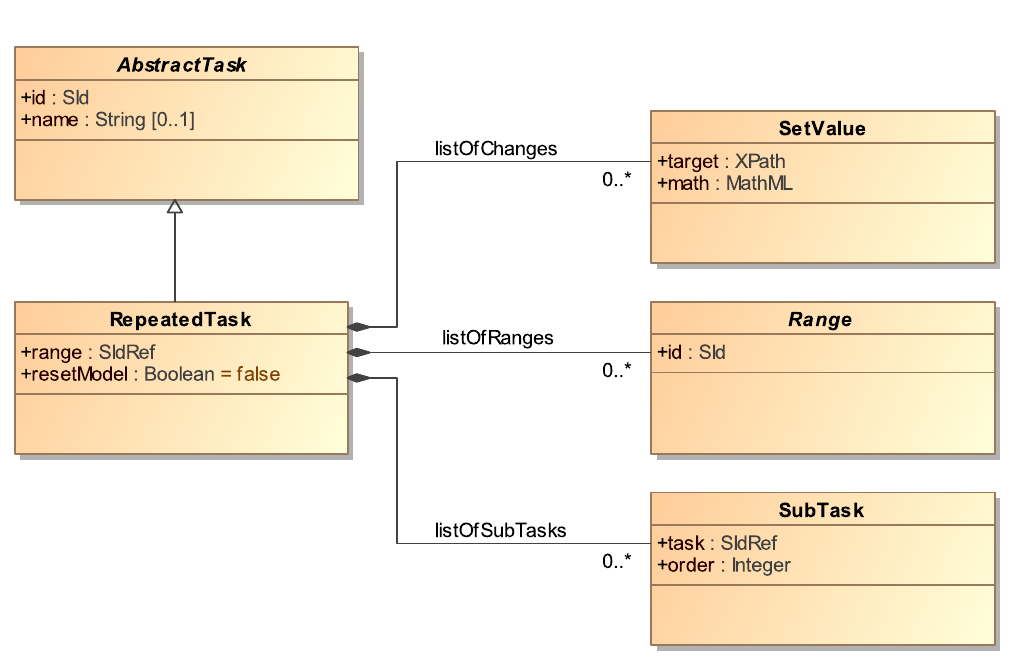
Figure 2.34: The SED-ML RepeatedTask class